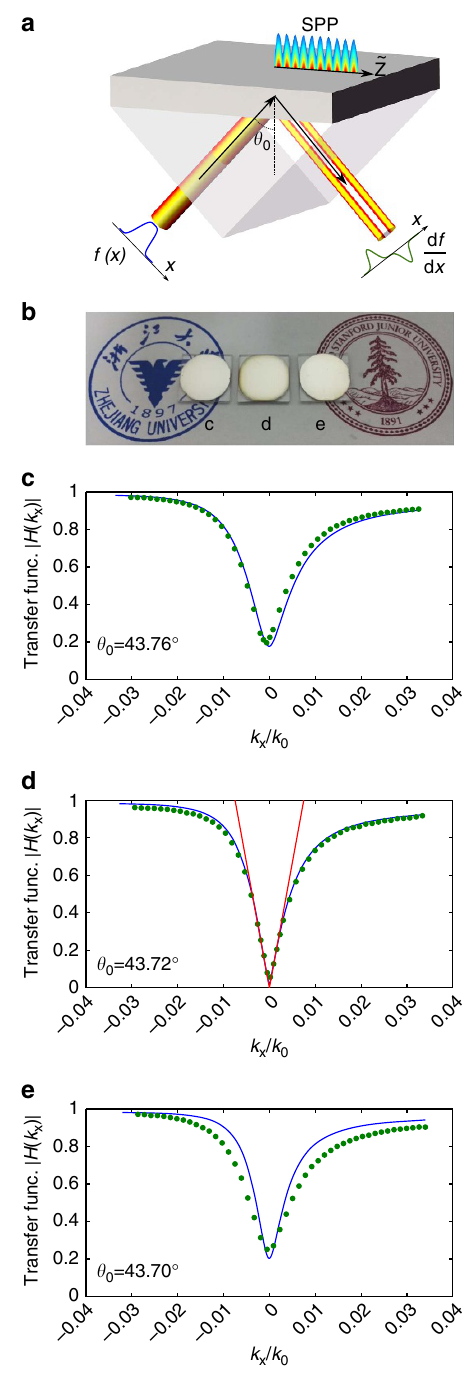
Figure 1 | Design of surface-plasmon-based spatial differentiator. ( a ) Schematic of the plasmonic spatial differentiator with the Kretschmann configuration to excite the surface plasmon polariton (SPP). The dark grey layer and the light grey area correspond to the silver film and the glass, respectively. ( b ) Sample photo of three deposited silver thin films with different thicknesses. ( c – e ) Spatial transfer function spectra of the three samples by the experimental measurement (dotted lines) and the numerical fitting (solid lines). In the numerical calculation, the thicknesses of the silver layer were 46.0, 50.0 and 55.5nm, respectively. y 0 corresponds to the incident angle for the phase matching. The red line in ( d ) corresponds to the fitting results to equation